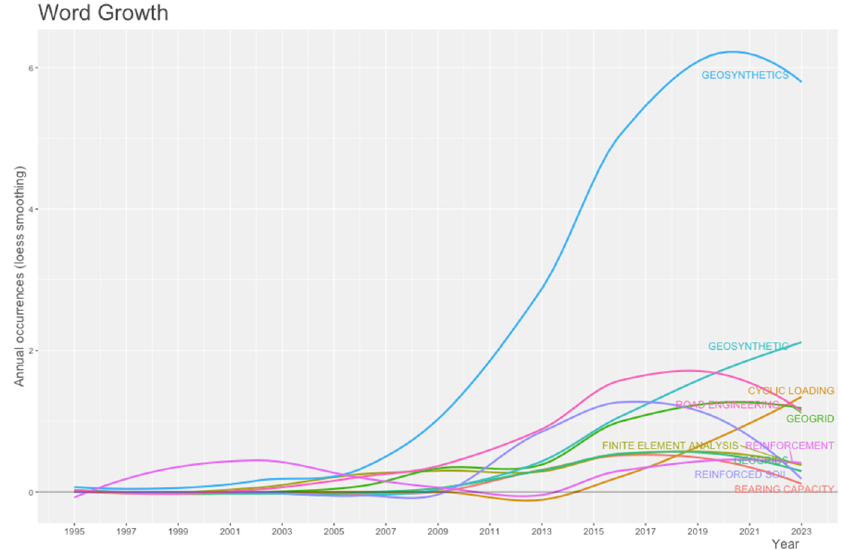
Figure 21. Word dynamics.